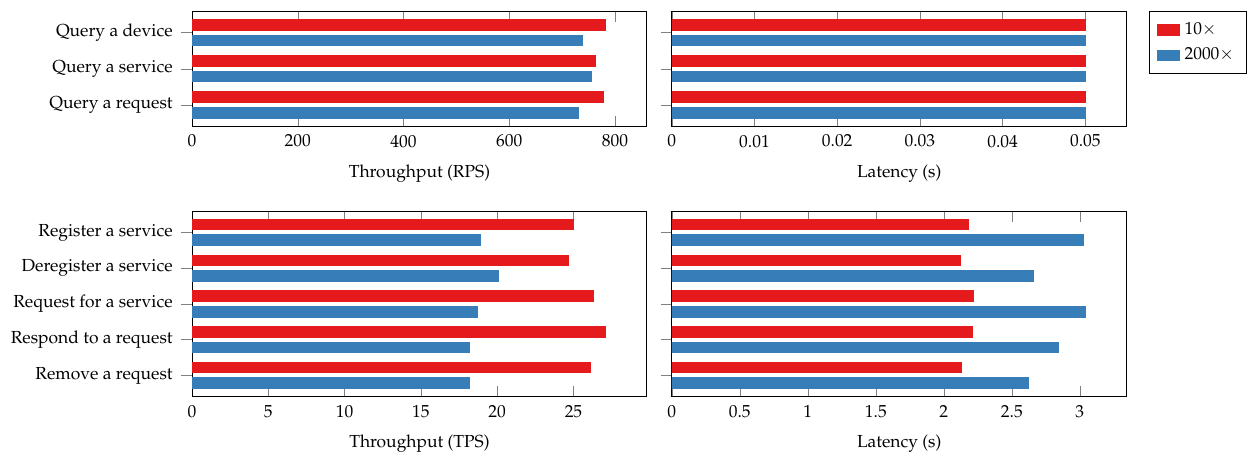
Figure 19. Throughput and latency of read and transaction operations for 10 client connections (10 × ) and 2000 client connections (2000 ×